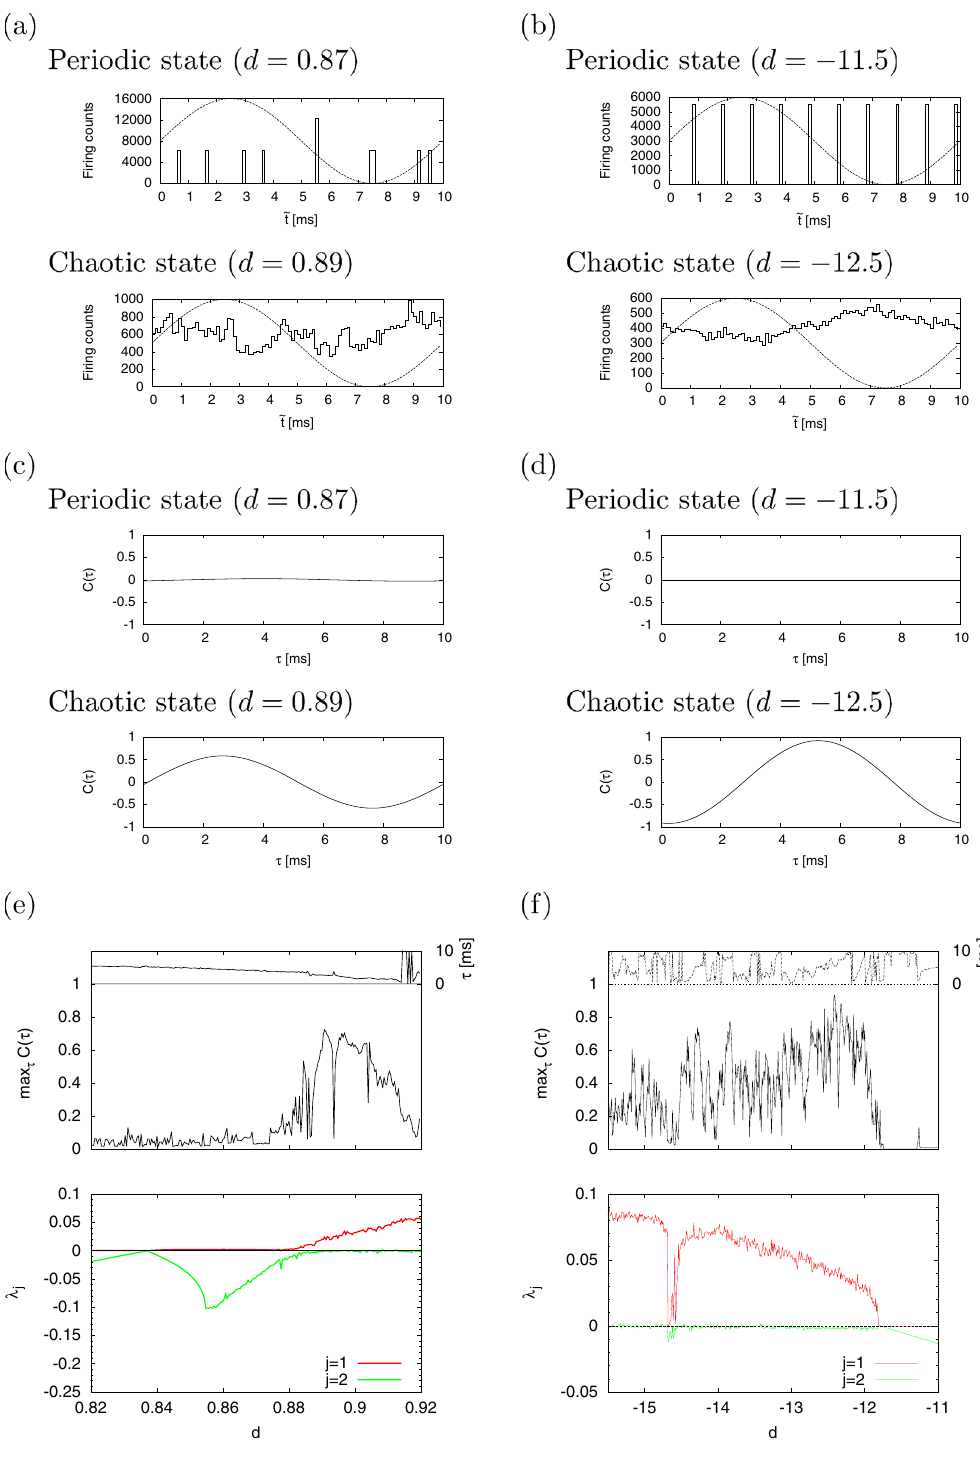
Figure 3. Dependence of signal response on parameter d . The cycle histogram ˜ F t ( ) of neuron spikes is congruent with the signal ˜ I t ( ) in chaotic regions, i.e., chaotic resonance (CR) arises. ( a ) Cycle histogram ˜ F t ( ) ext in the periodic state (upper) and the chaotic state (lower) in the case of region #1. ( a = 0.02, b = 0.2, c = − 55, I = 10). ( b ) The case of region #2. ( a = 0.2, b = 2, I = − 99). ( c ) Mutual correlation C ( τ ) between the cycle ˜ F t ( ) of the neuron spikes and the signal ˜ I t ( ) in the case of region #1. ( d ) The case of region #2. ( e ) ext max τ C ( τ ) (upper) and Lyapunov exponent λ j ( j = 1, 2) (lower) as a function of parameter d in the case of region #1. ( f ) The case of region